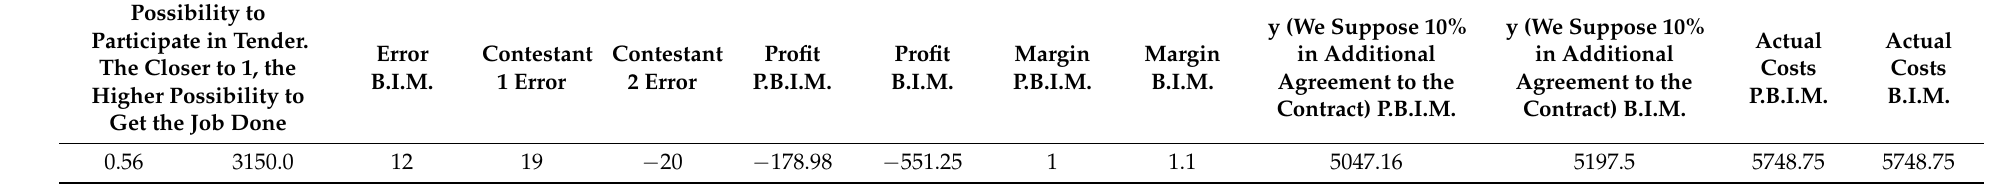
Table 3. Fragment of the spreadsheet list “Journal of